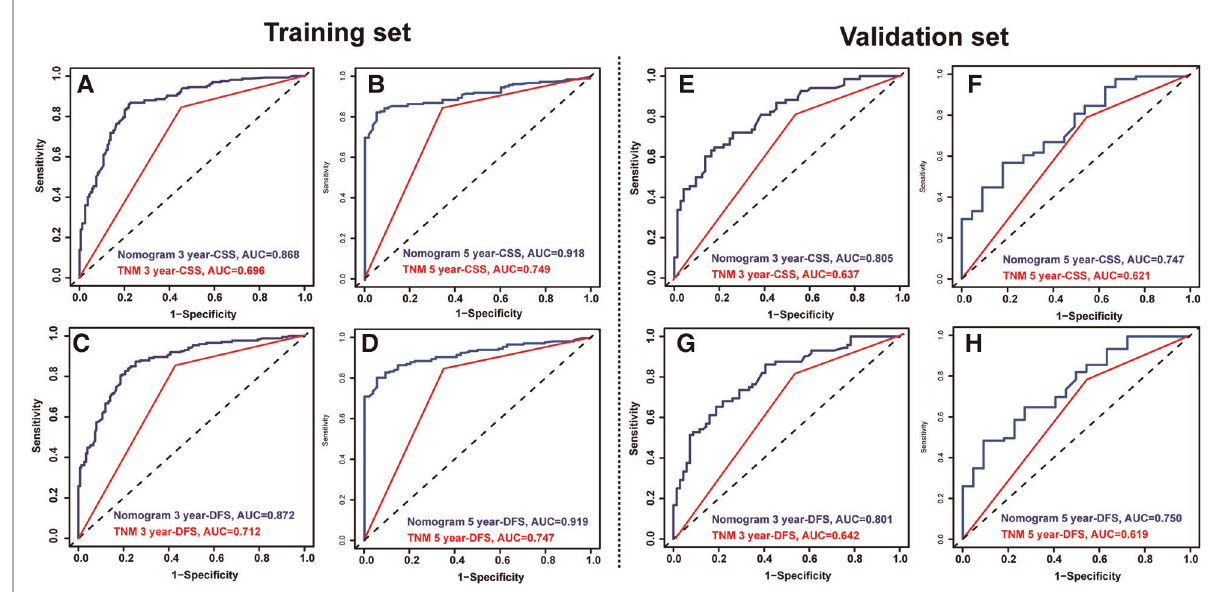
FIGURE 3 Time-dependent reciever operating characteristics (ROC) curves of nomograms and TNM staging were used to test the predictive power of the 3-year cancer-speci fi c survival (CSS) ( A ) and 5-year CSS ( B ), 3- year disease-free survival (DFS) ( C ) and 5-year DFS ( D ) in the training set. Time-dependent ROC curves of nomograms and TNM staging were used to test the predictive power of the 3-year CSS ( E ) and 5-year CSS ( F ), 3- year DFS ( G ) and 5-year DFS ( H ) in the validation